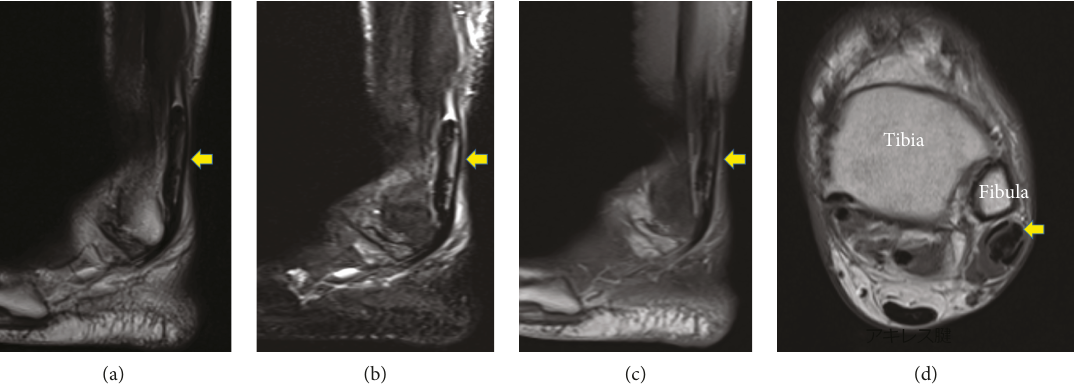
Figure 3: Sagittal T1- and T2-weighted MR images showed an elliptical mass of low intensity partially with high intensity with no contrast e ff ect. Axial T1-weighted MR images showed a low-intensity mass (yellow arrow) in the peroneal tendon sheath, which seemed to compress both the peroneal brevis and longus tendons. (a) Sagittal T1-weighted image. (b) Sagittal T2-weighted image. (c) Sagittal enhanced image. (d) Axial T1-weighted image.